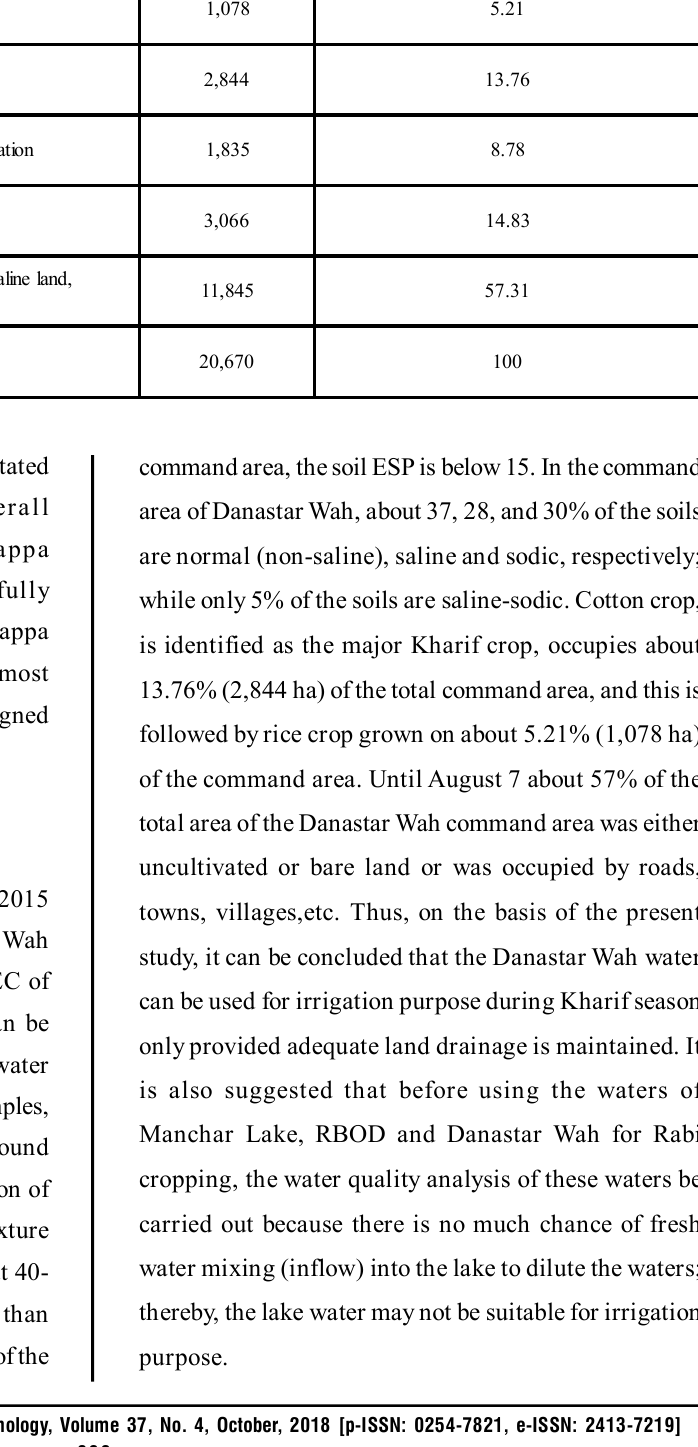
TABLE 1. LAND UTILIZATION OF THE COMMAND AREA OF DANATAR WAH (AUGUST 7, 2015)